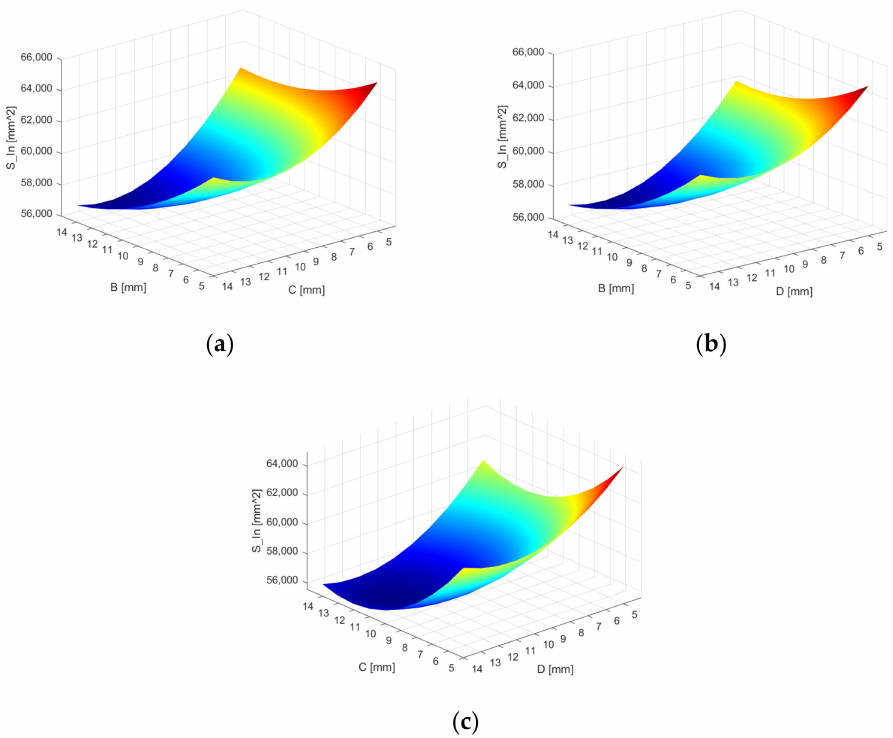
Figure 14. Response surfaces of S_In: ( a ) effect of thickness of parameters B and C on S_In; ( b ) effect of thickness of parameters B and D IV on S_In; ( c ) effect of thickness of parameters C and D on